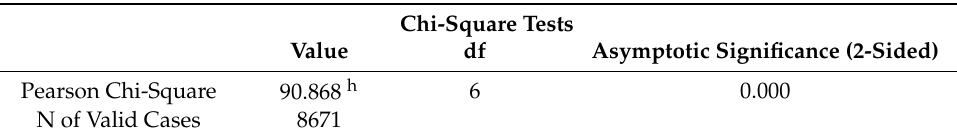
Table 21. Chi-square test (enterprise size vs. change in the ROS 2020 profitability indicator). Source: own research.